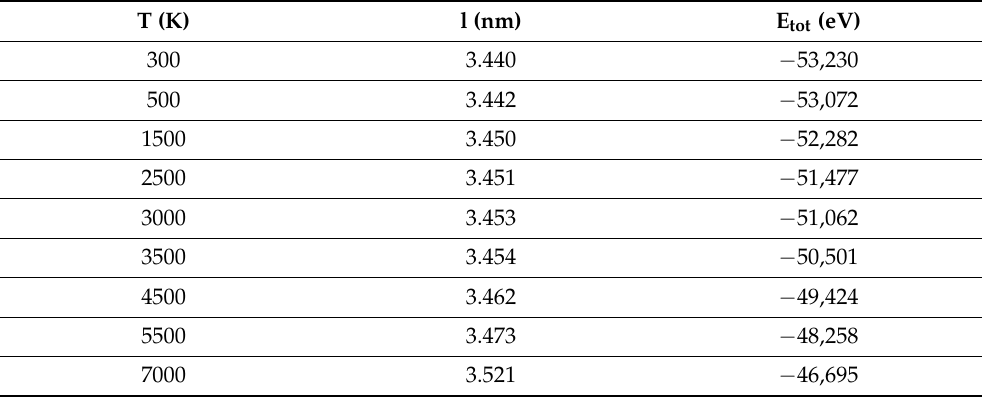
Table 4. The l and E tot of bulk SiO 2 at different T values.